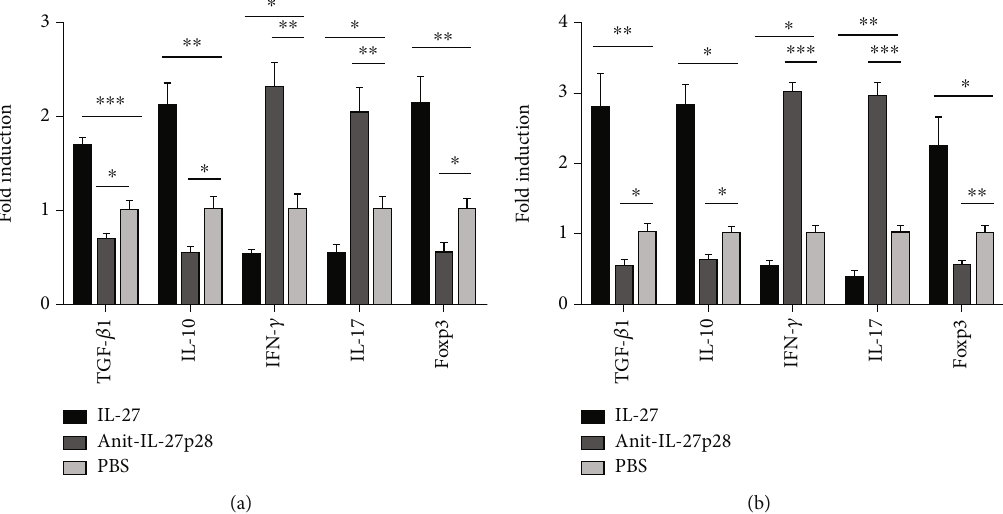
Figure 7: Recombinant IL-27 reduced the expression of IFN- γ and IL-17A while increasing the expression of TGF - β the aorta. The expression of associated genes in the aorta during the initiation (a) and the progression (b) of atherosclerosis were detected by qPCR. Groups data are shown in histogram. ∗∗∗ P < 0 : 001 , ∗∗ P < 0 : 01 , ∗ P < 0 : 05 .